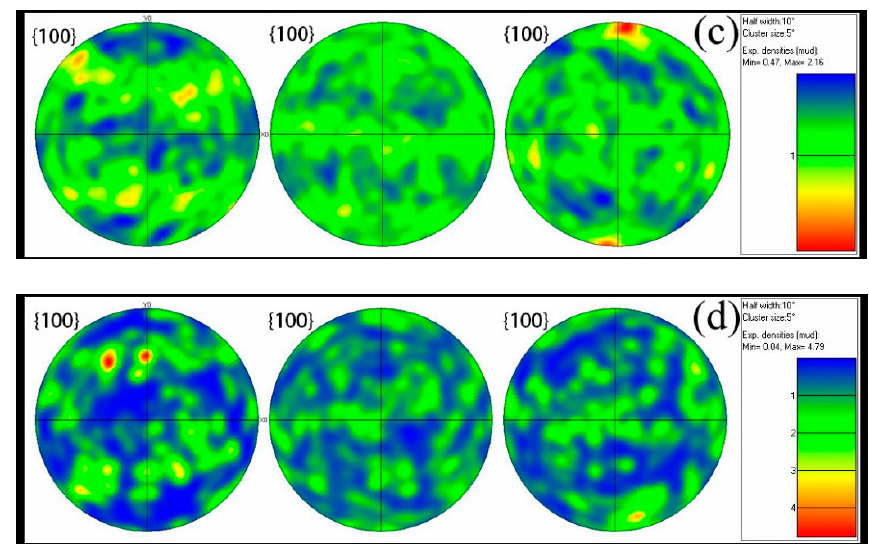
Figure 10. The pole figures of the Inconel625 alloy at different temperatures. ( a ) 900 °C; ( b ) 1000 °C; ( c ) 1100 °C; ( d ) 1200 °C.